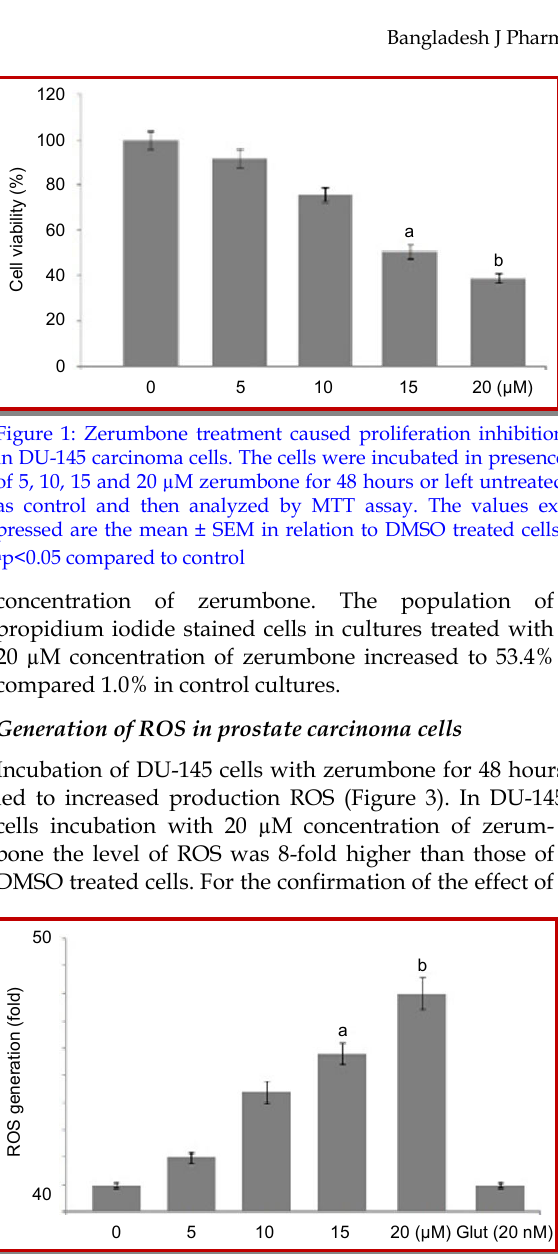
Figure 3: Zerumbone treatment induced production of ROS in prostate carcinoma cells. The cells were treated with different doses of zerumbone for 48 hours and then then analyzed for ROS generation using DCFH-DA dye zerumbone on production of ROS, the cells were treated with glutathione. Exposure of the zerumbone treated cells to glutathione inhibited the